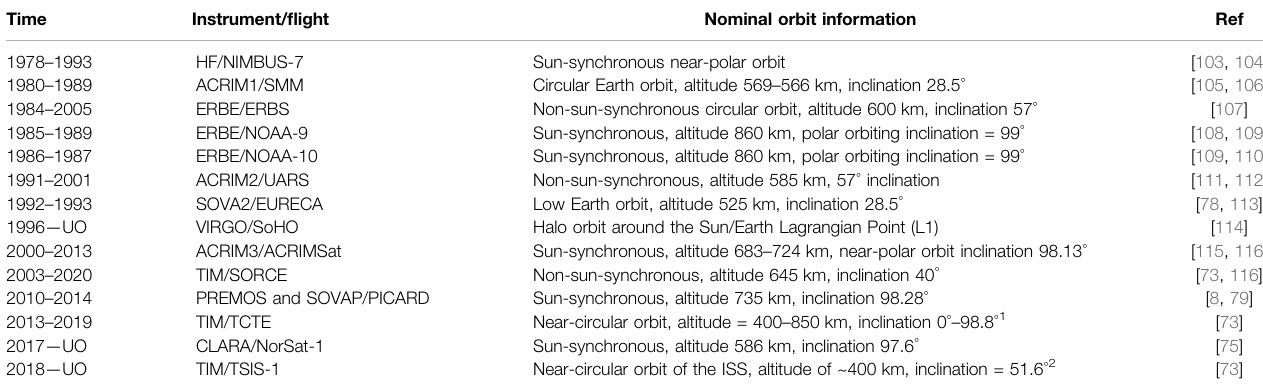
TABLE 1 | Summary of the missions to monitor TSI since 1978. Some fl ights are under operation (UO).